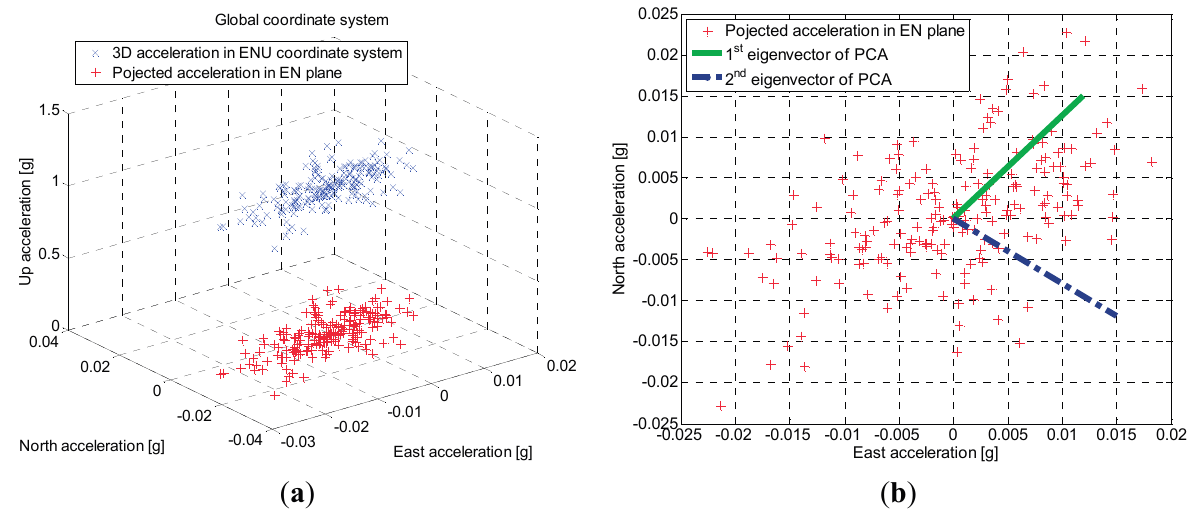
Figure 13. Illustration of heading determination by employing principal component analysis (PCA): ( a ) Description that three-dimensional acceleration is projected to global horizontal plane; ( b ) Eigenvectors extraction from the acceleration of horizontal plane to determine the heading of a